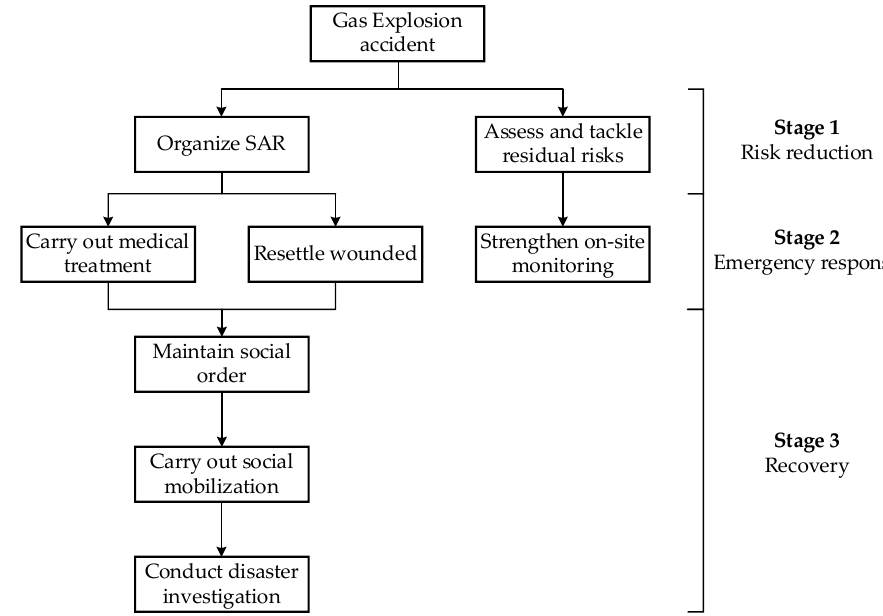
Figure 6. Technical framework for SAR operations following gas